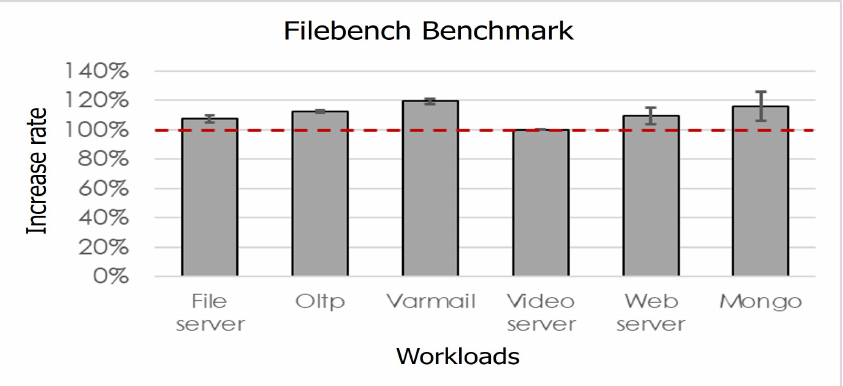
Figure 10. I/O performance comparison between Virtio and Direct-Virtio for macro workloads (100% baseline is